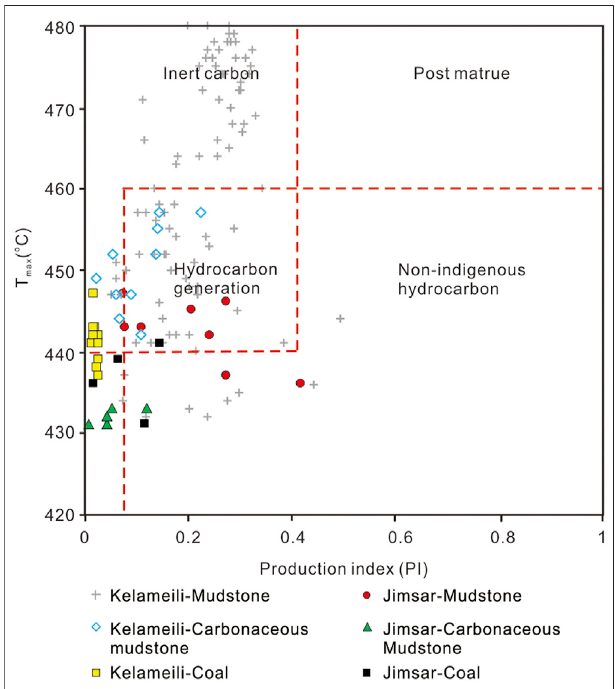
FIGURE 4 | The PI vs T max plot of C 1 s b source rocks in the Jimsar Sag and Kelameili gas fi eld.